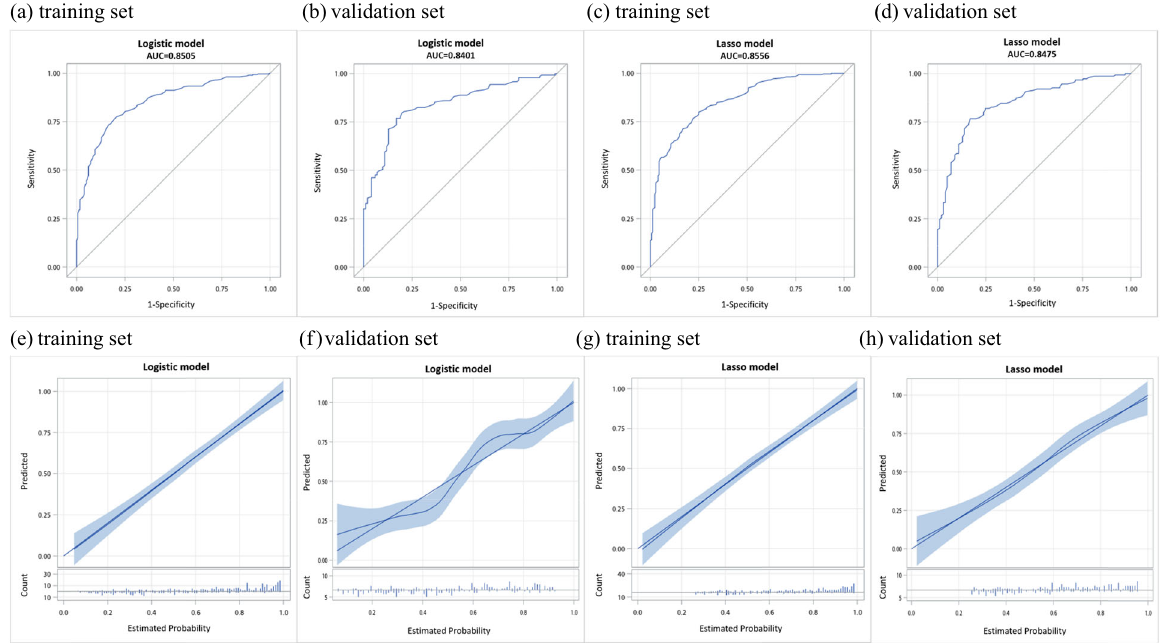
Fig. 3 Receiver operating characteristic (ROC) curves and calibration curves for evaluating the discrimination performance of logistic regression and Lasso regression models in both training and validation cohorts. a – d ROC curves showing the capabilities of logistic regression and Lasso regression methods in predicting schizophrenia risk. e – h Calibration plot with a binary fringe plot of logistic regression and Lasso regression